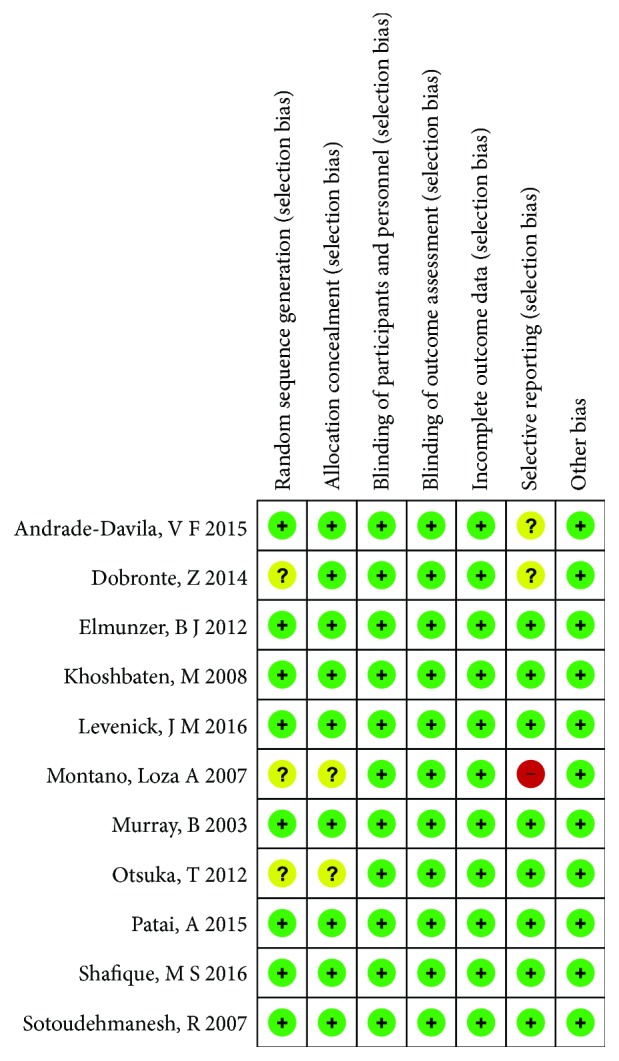
Consensus risk of bias assessments of the included studies. Green: low risk; yellow: unclear risk; red: high risk.